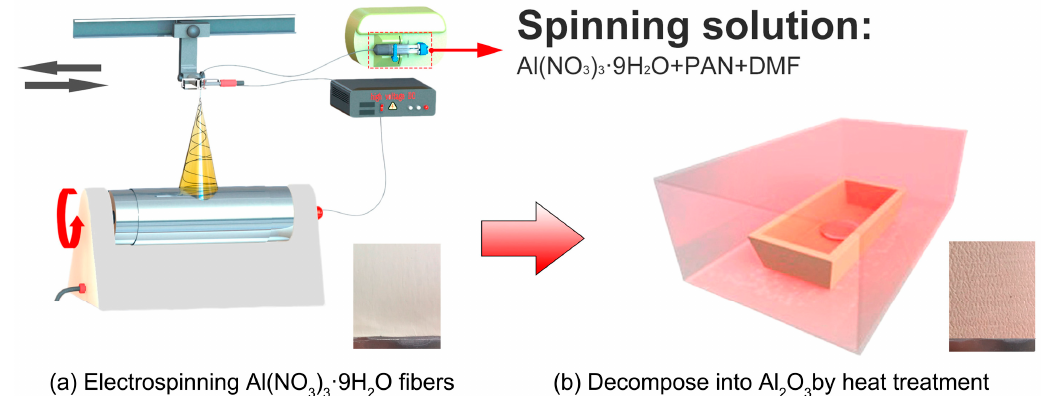
Figure 4. Electrospun Al(NO 3 ) 3 ·9H 2 O, polyacrylonitrile (PAN) and N,N-dimethylformamide (DMF) mixed solution on zinc substrate ( a ). Heat treatment of the electrospun films in muffle furnace in an atmospheric environment to obtain Al 2 O 3 coatings ( b ). Reprinted with permission of [51].